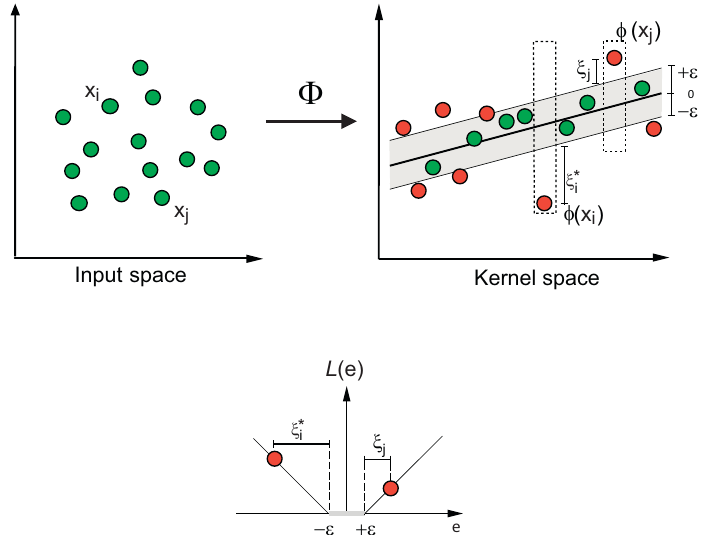
Figure 2. Example of a support-vector-regression process for a two-dimensional regression problem, with an (cid:101) -insensitive loss